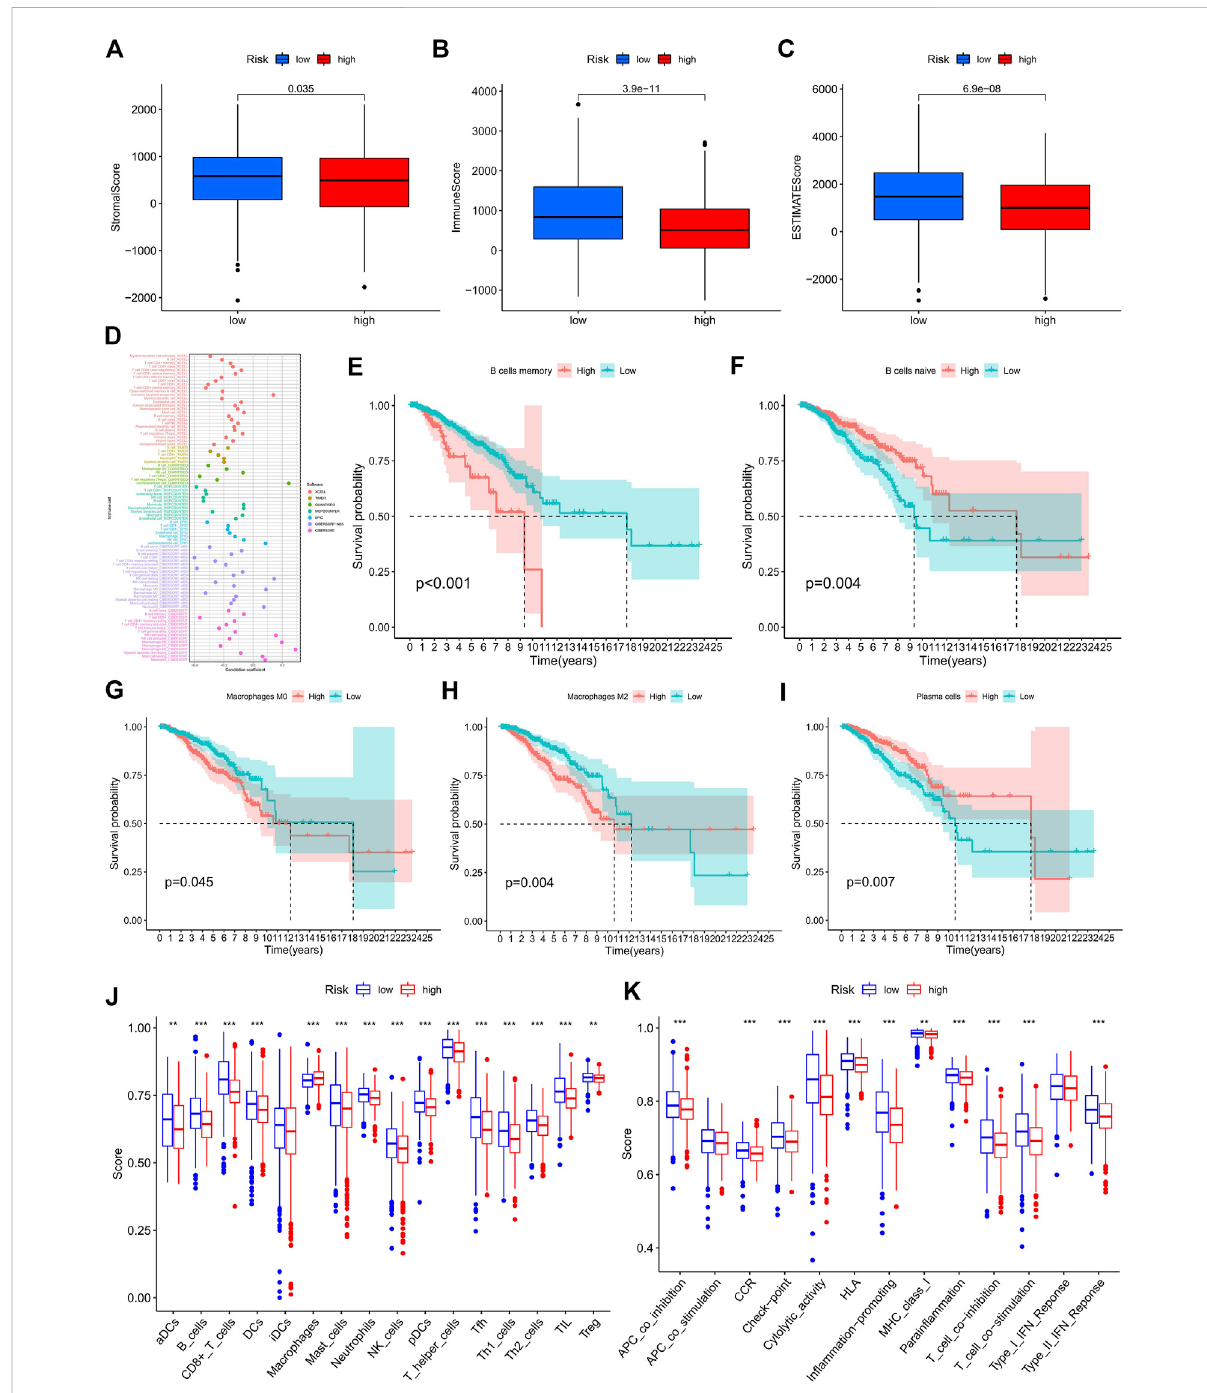
FIGURE 6 Exploration of the tumor immune status. (A – C) The boxplots for StromalScore (A) , ImmuneScore (B) , and ESTIMATEScore (C) in the high- and low-risk groups. (D) Estimation of immune-in fi ltrating cells in BC by using the Spearman correlation analysis. (E – I) Kaplan – Meier survival curves of screened B memory cells (E) , B naive cells (F) , Macrophages M0 (G) , Macrophages M2 (H) , and plasma cells (I) in BC patients. (J – K) The score of the in fi ltrating immune cells (J) and immune-related functions (K) in the high- and low-risk groups. BC, breast cancer; *, p < 0.05; **, p < 0.01; ***, p <